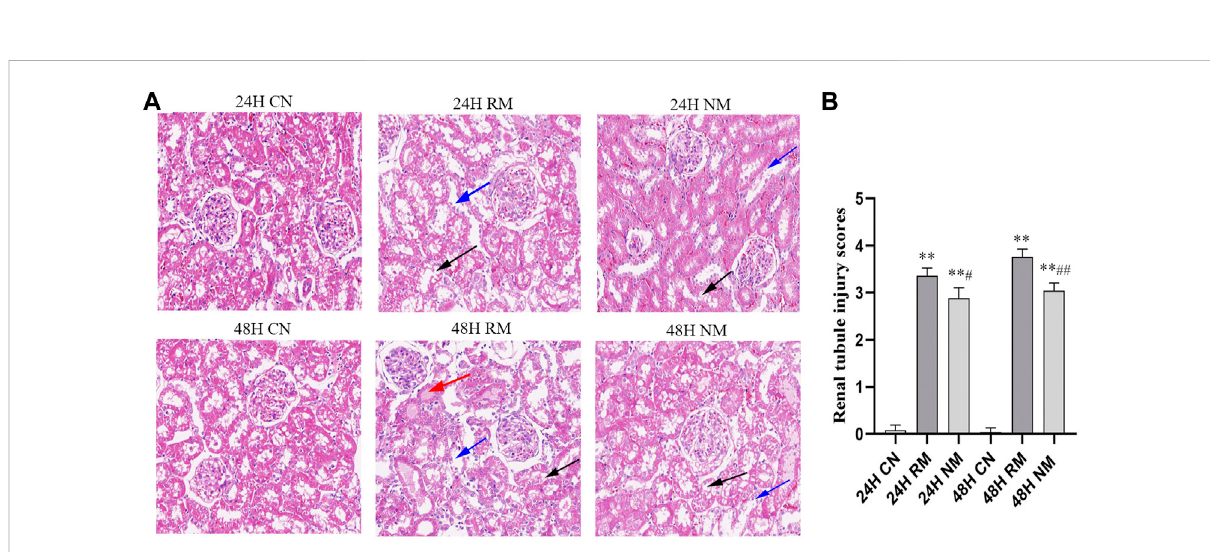
FIGURE 3 Effect of NM on renal histopathology in RIAKI. (A) Representative histological appearance of kidney tissue using H&E staining presented with magni fi cation ×200. The black arrow indicates renal tubular necrosis and detachment; the blue arrow indicates renal tubular vacuole; the red arrow indicates the cast in the renal tubules. (B) Renal tubular injury scores (** p < 0.01 vs. CN; # p < 0.05, and ## p < 0.01 vs.